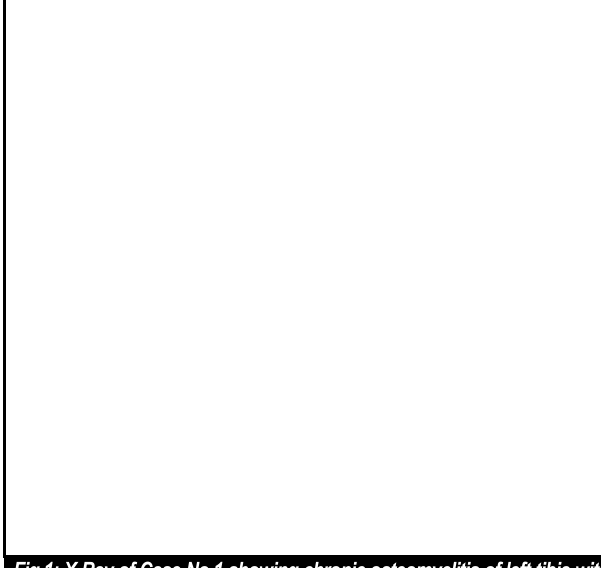
Fig.1: X-Ray of Case No.1 showing chronic osteomyelitis of left tibia with involvement of almost the whole of the bone except the lower